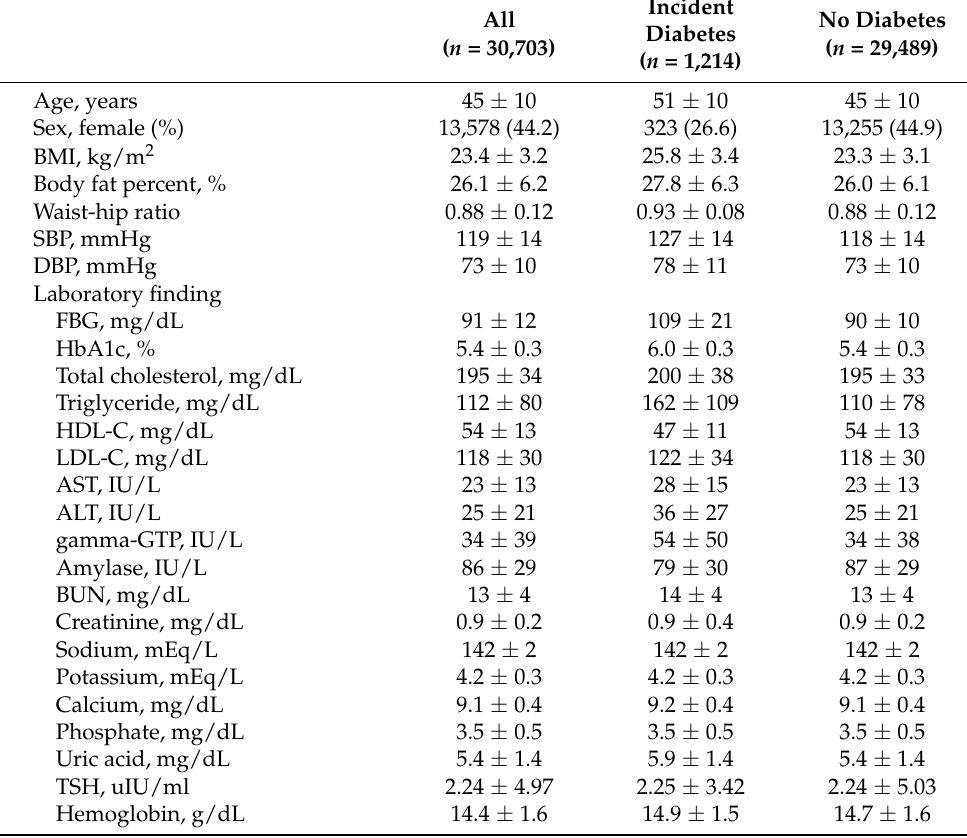
Table 1. Characteristics of the subjects in training